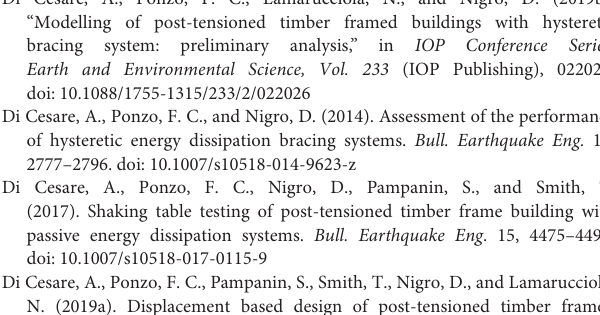
(B) composed of two timber rods and a hysteretic damper (D) realized with two UFPs, with two braces for each